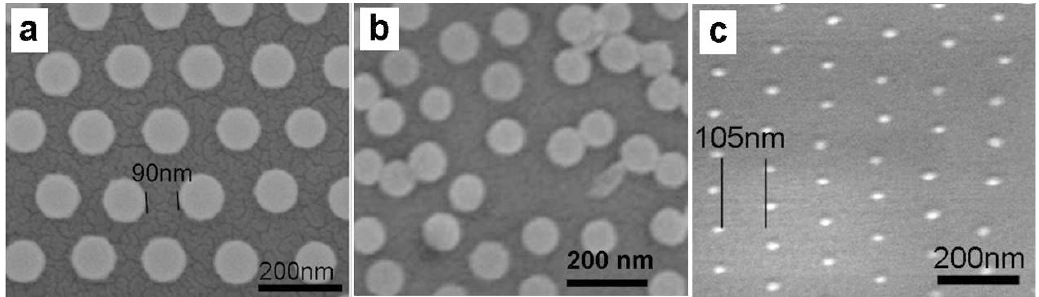
Figure 4. SEM images of the as-self assembled PS colloidal monolayer after Ar + plasma etching. ( a ) and ( b ): After etching for 6 min and 7 min., respectively, for the monolayer with 200 nm in initial diameter of PS sphere. ( c ): After alternately heating (at 120 °C for a few seconds) and etching several times for the monolayer with 120 nm in initial diameter of PS sphere (100 W in input power for etching).